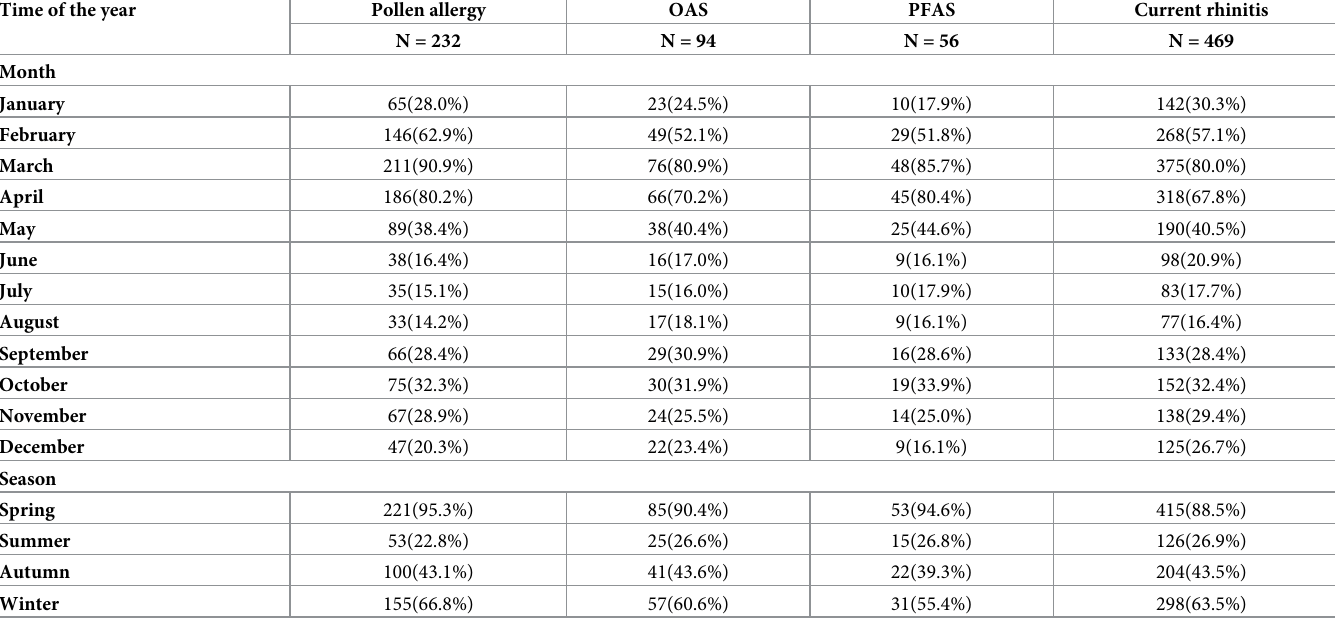
Table 4. Seasons of the children showing symptoms of rhinitis at 13 years old.